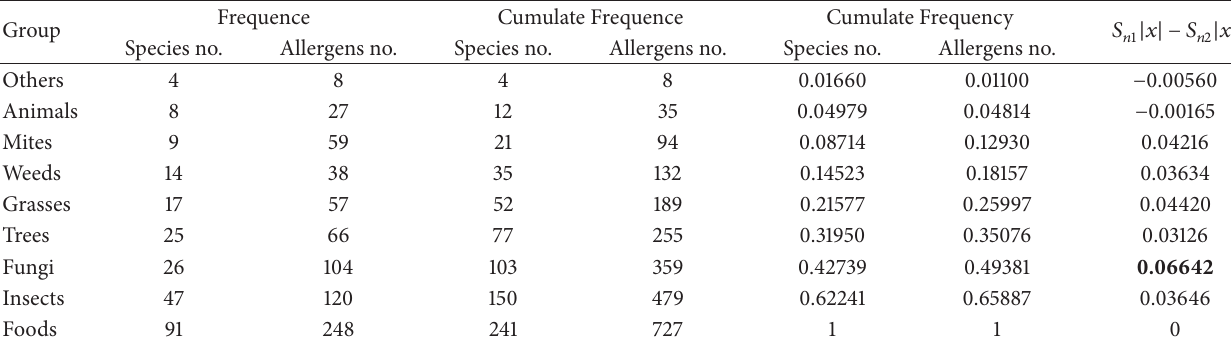
Table 1: Parameter estimate for Kolmogorov - Smirnov test (Complementary for Figure 2) ∗ .